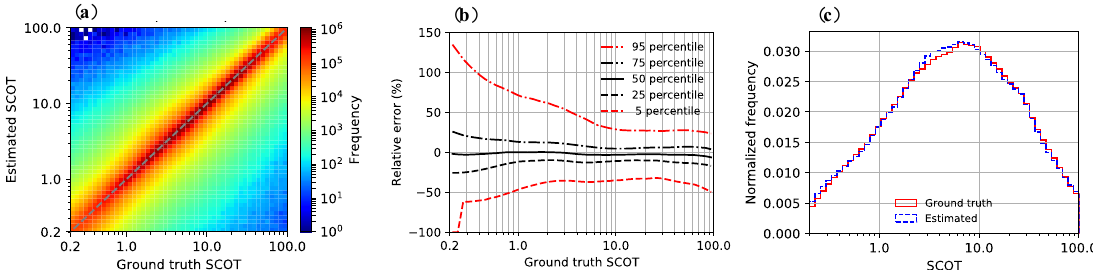
Figure 11 . Evaluation of SCOT estimation by the CNN for the test dataset: ( a ) joint histogram of the estimated and ground-truth SCOT, with an occurrence frequency denoted by color shades; ( b ) relative error of the estimated SCOT as a function of the ground-truth SCOT; ( c ) comparison of histograms of the estimated and ground-truth SCOT.